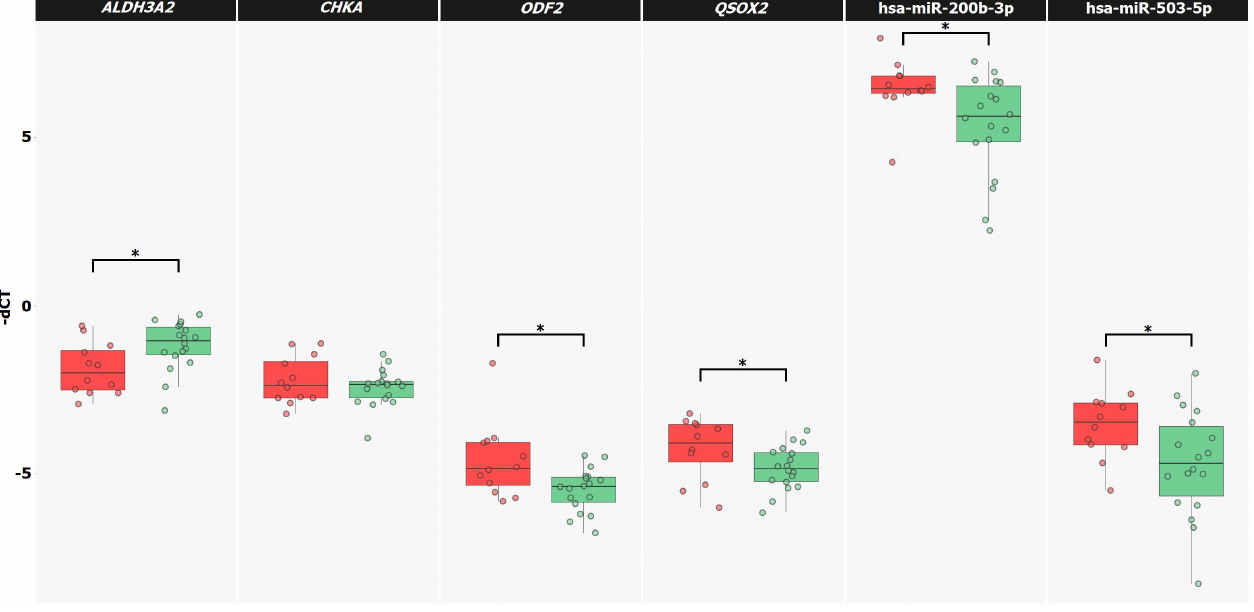
Figure 5. The relative expression of mRNA and miRNA for the unfavorable prognosis group is marked in red, and, for the favorable prognosis group, green. *—significant alteration. Table 4. Alteration in relative expression between BCR and BRF groups. FC—fold change